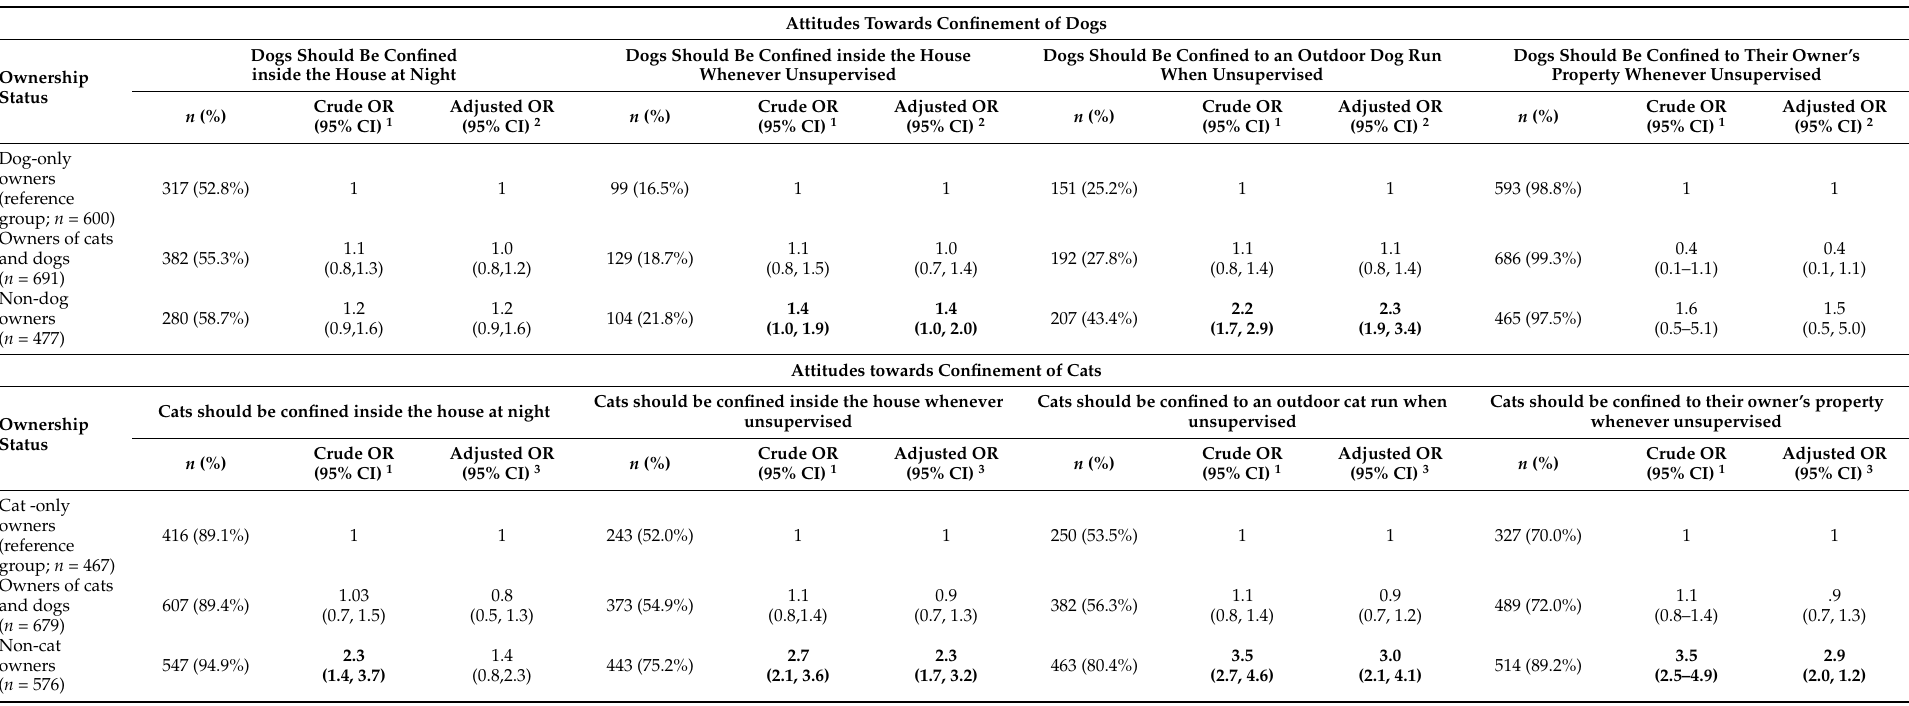
Table A1. Associations of pet ownership status and agreement (agree and strongly agree) to statements about confinement of pet dogs and pet cats. Attitudes Towards Confinement of